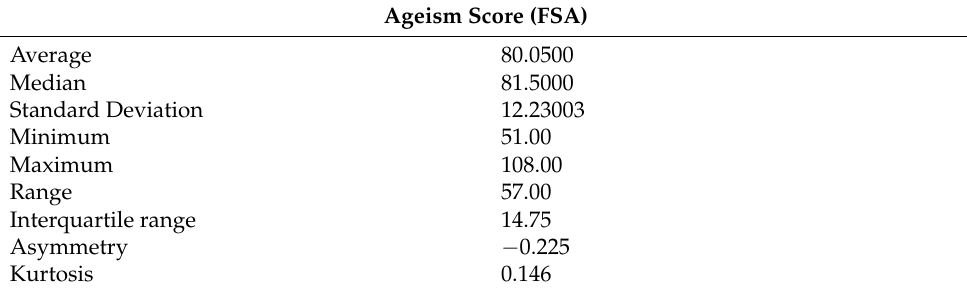
Table 3. Ageism score